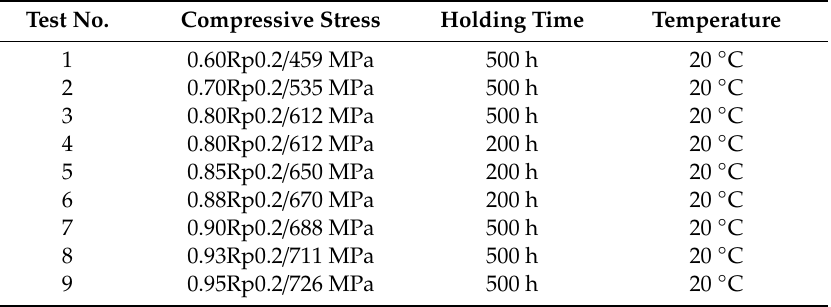
Figure 3. Compression creep specimen. Table 2. Processing parameters used in the present study